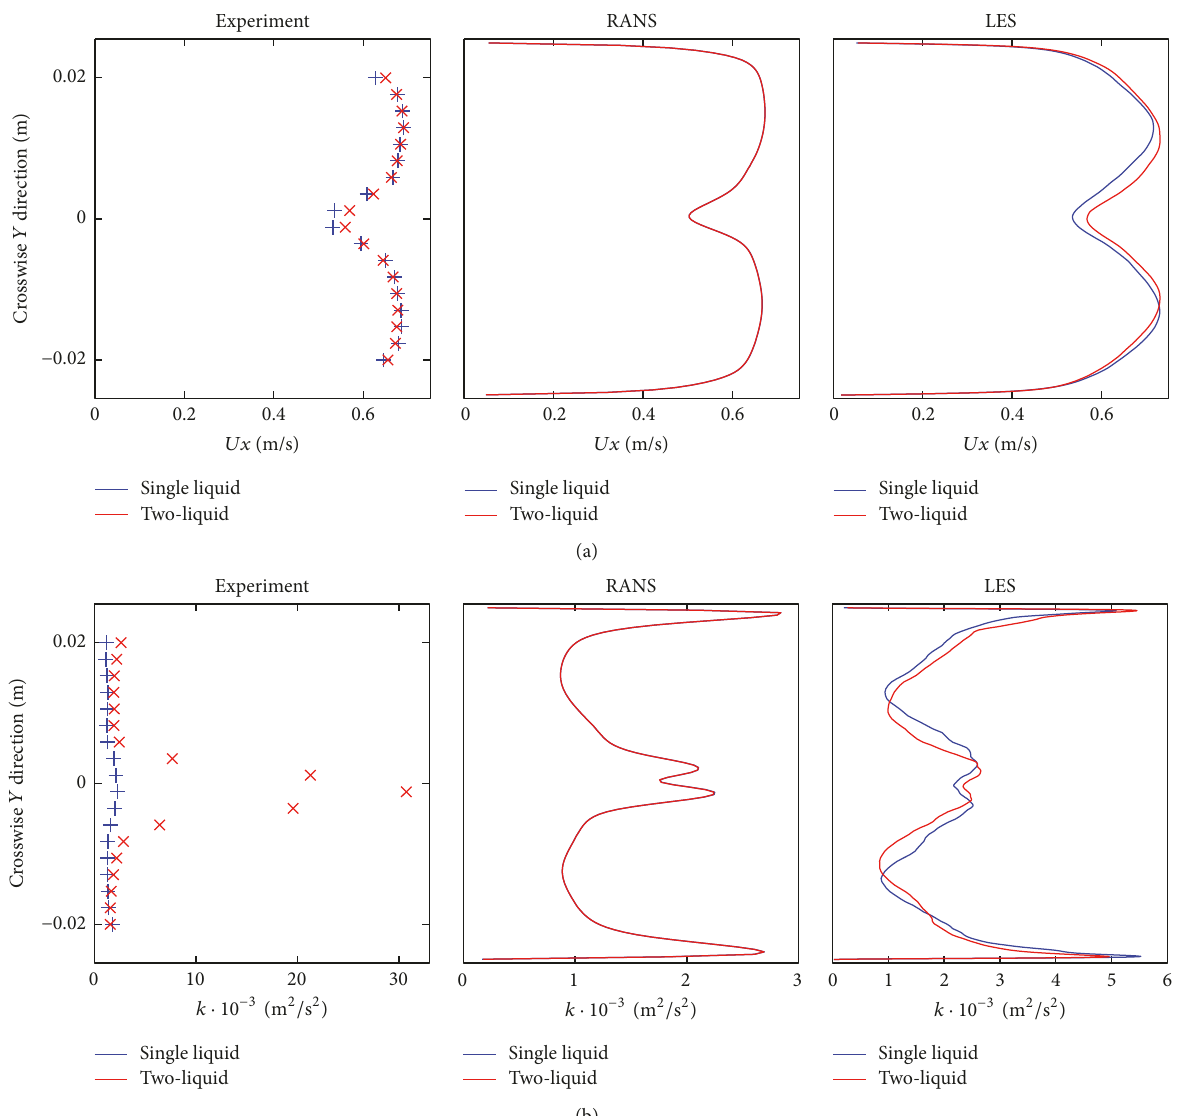
Figure 11: Comparison of the velocity profiles (a) and turbulence kinetic energy (b) in the single liquid and two-liquid case at 𝑥 = 0.05 m.